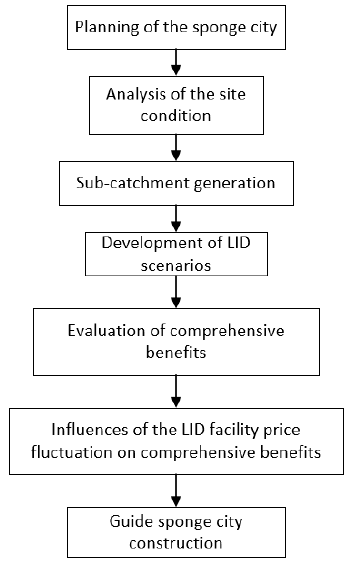
Figure 1. The evaluation process of comprehensive performance.